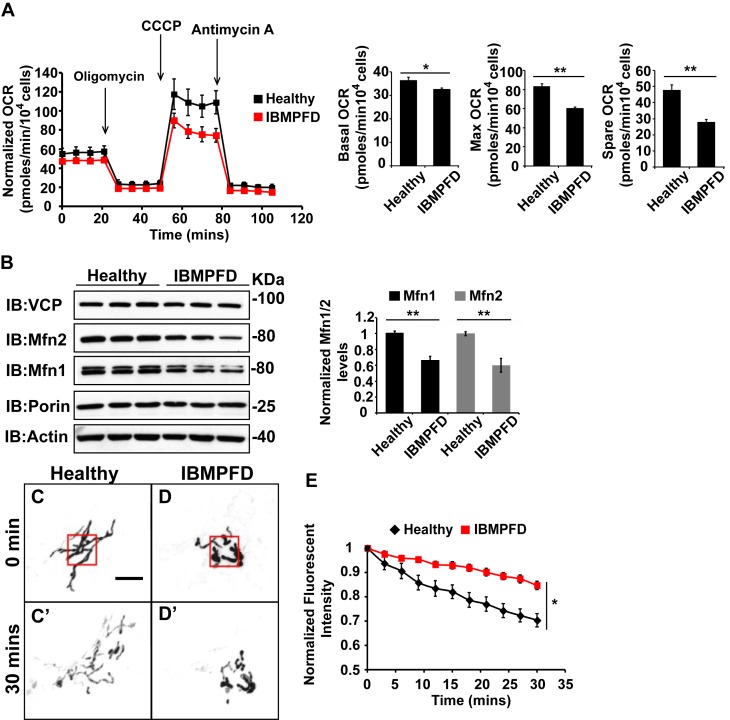
IBMPFD patient cells carrying the VCPR155H/+ mutation have decreased Mfn 1 and Mfn 2 levels and reduced mitochondrial fusion.(A) Oxygen consumption rates (OCR) in healthy control and IBMPFD patient fibroblasts. Inhibitory drugs were added at the time points indicated. Basal levels of OCR (p=0.026, independent t test, N = 8) and maximum (CCCP-stimulated) OCR (p=3.74E-06, independent t test, N = 8) are both decreased in the IBMPFD patient fibroblasts. The spare OCR is also significantly decreased (p=0.000024, independent t test, N = 8). (B) Mfn 1 and 2 levels are consistently decreased in three independent lysates from the IBMPFD patient fibroblasts when compared to the healthy control. Mfn 1 levels in patient fibroblasts are reduced to 0.66 ± 0.14 of the controls (p=0.001, independent t test, N = 5); Mfn 2 levels are reduced to 0.60 ± 0.14 of the controls (p=0.008, independent t test, N = 5). **p<0.01. Normalized Mfn 1 and 2 levels are shown as mean±½SD. (C–D’) Mitochondrial fusion assay utilizing photoactivatable mitoGFP (PA-GFP) in healthy control and IBMPFD patient fibroblasts. After laser photoactivation of a region (Red hollow square in C and D), cells were tracked for 30 min. (E) PA-GFP signal intensity (throughout the whole cell) is recorded every 3 minutes, and the rate of decrease of average GFP signal is a measure of mitochondrial fusion. Fusion rates are significantly decreased in the IBMPFD patient fibroblasts when compared to the healthy control (C’, D’ and E, independent t test, *p<0.05).